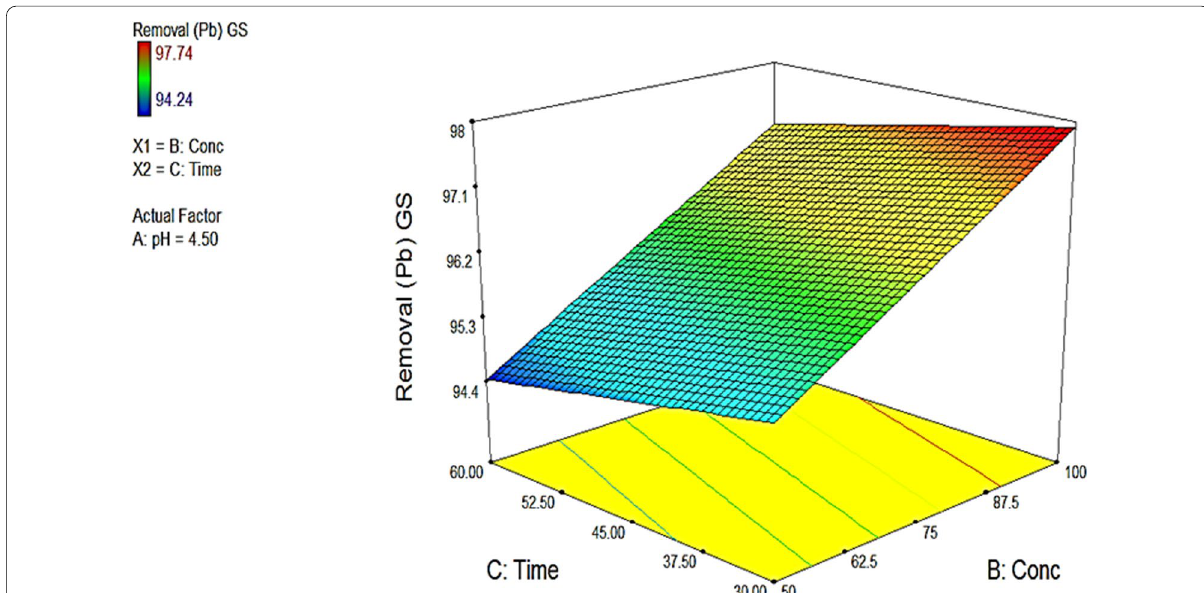
Fig. 4 A 3-dimensional plot of concentration and pH against the percentage removal of lead when groundnut shell residues are used as adsorbent